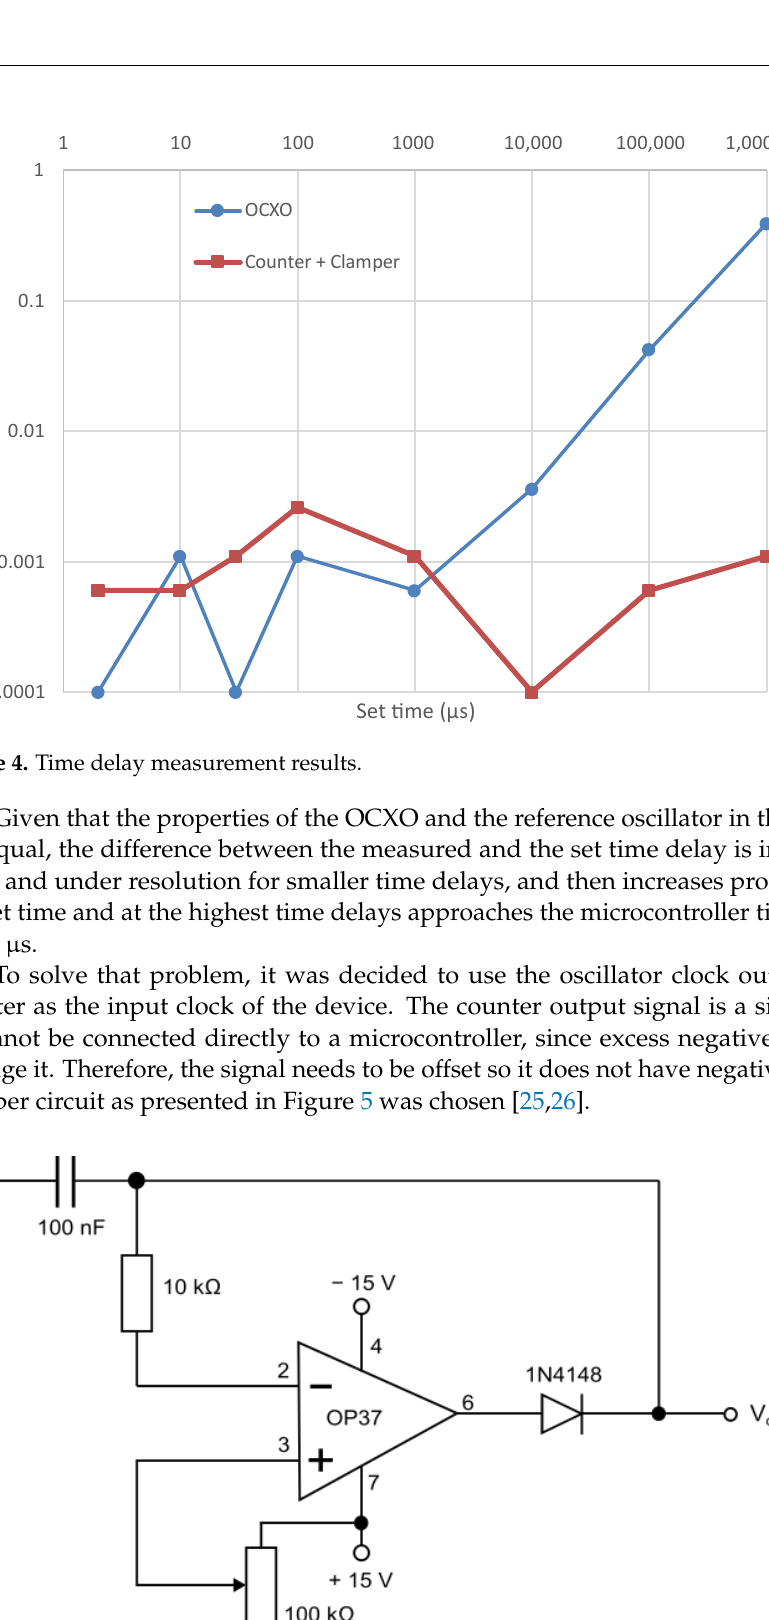
Figure 5. Clamper circuit [25,26].